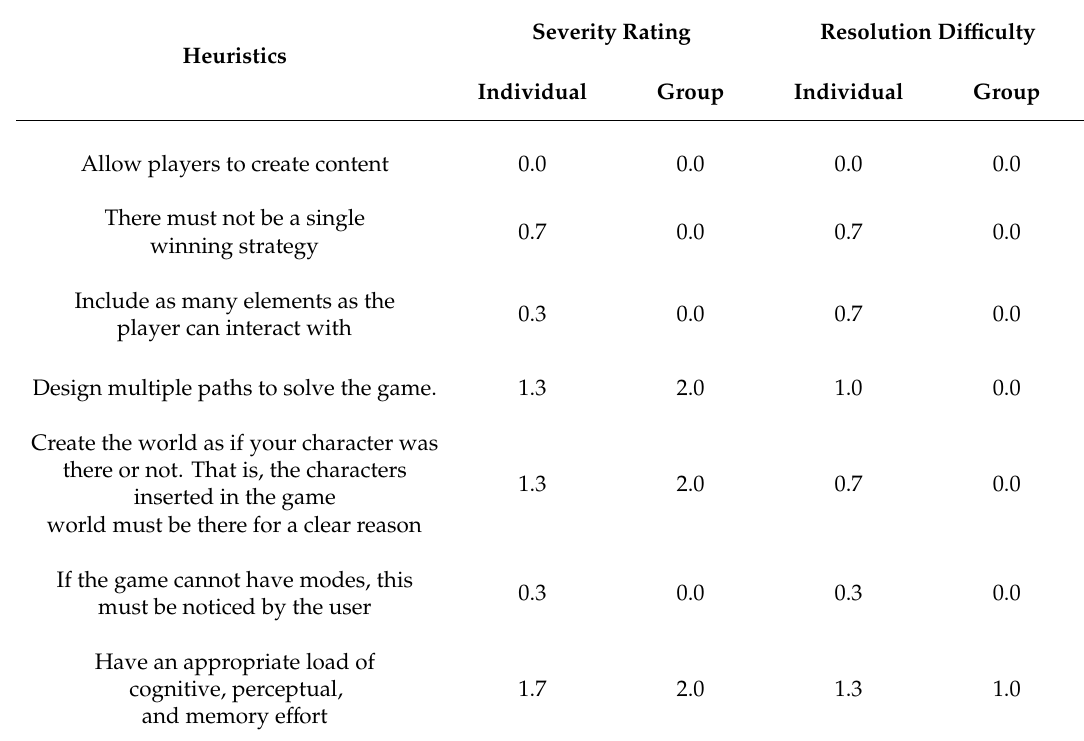
Table 4. Heuristics analysis of the game’s choices